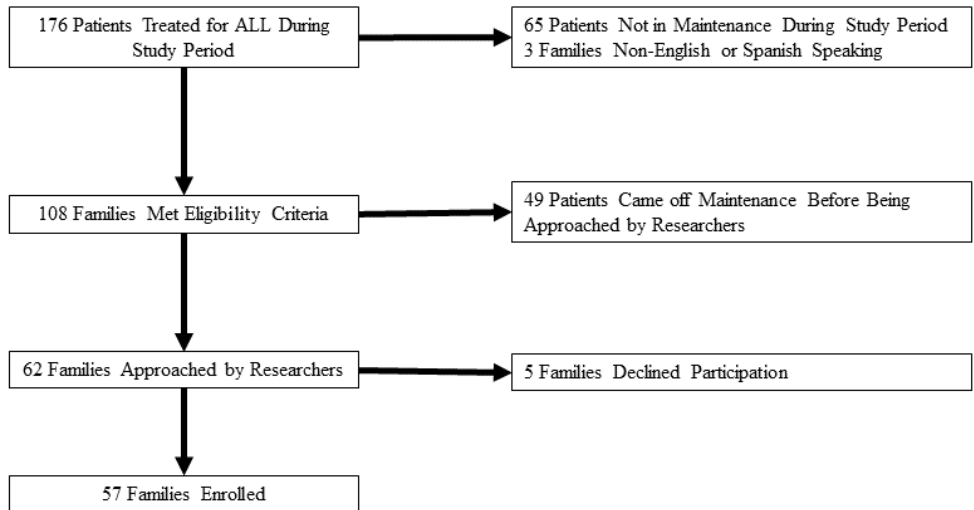
Figure 1. Enrollment